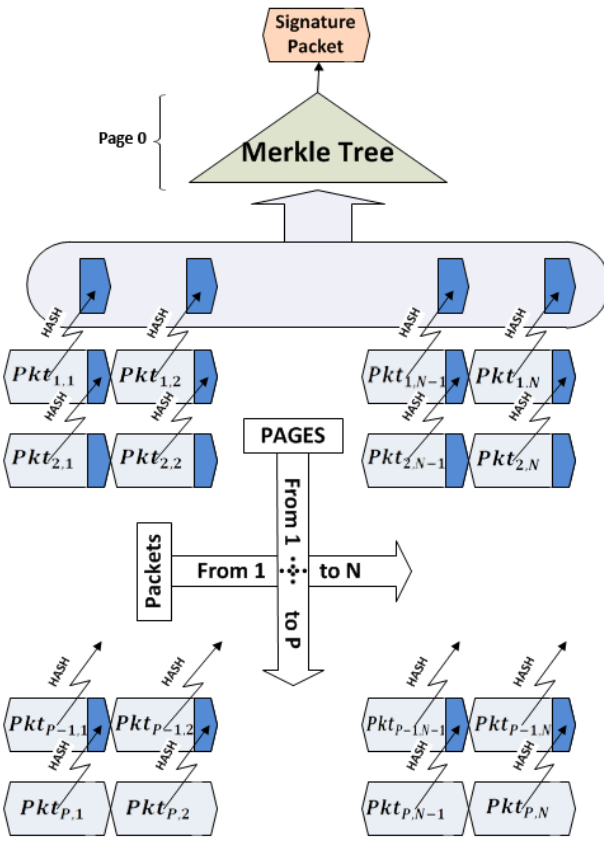
Figure 1. Authentication and integrity check of the code image in Seluge (adapted from [12]).